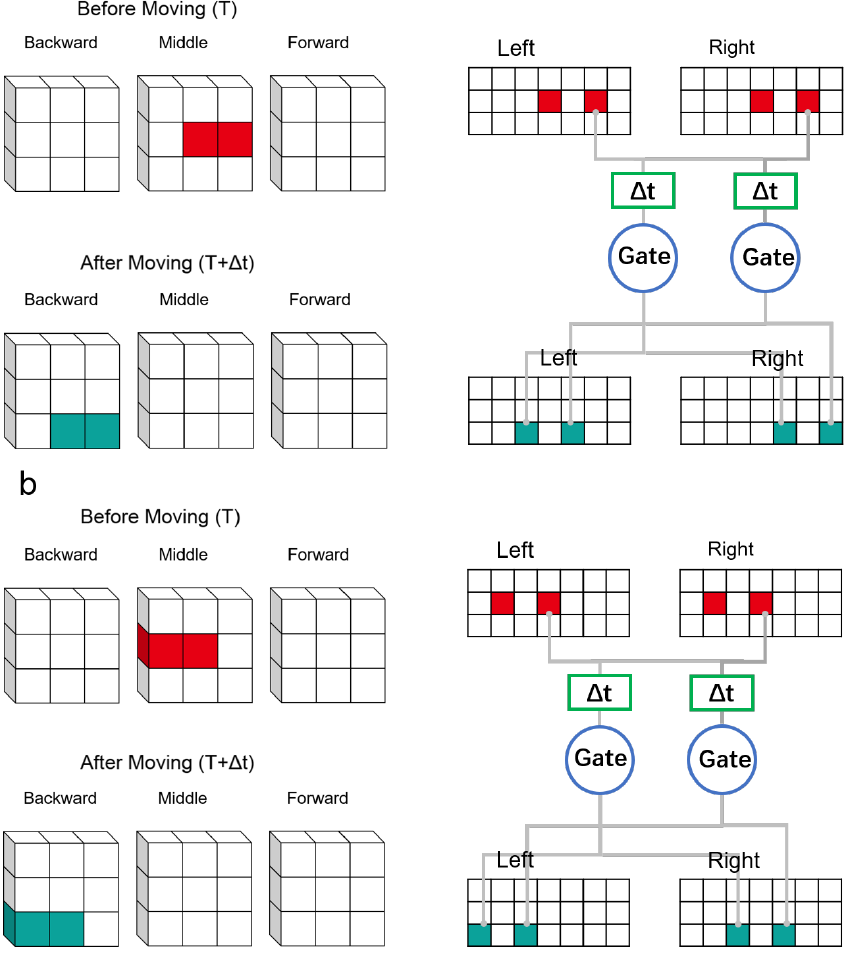
Figure 6. The position of the object in space ( Left ) and the projection of the object in the retina ( Right ), twenty-six local motion direction detection neurons are used to detect region from (1,1) to (3,7) over the two-dimensional retina receptive field. The red block represents the object before moving and the green block represents the object after moving. AND gate and delay channel are displayed in the right half of the figure. The figure shows how motion information of a 2 voxel object is processed in the